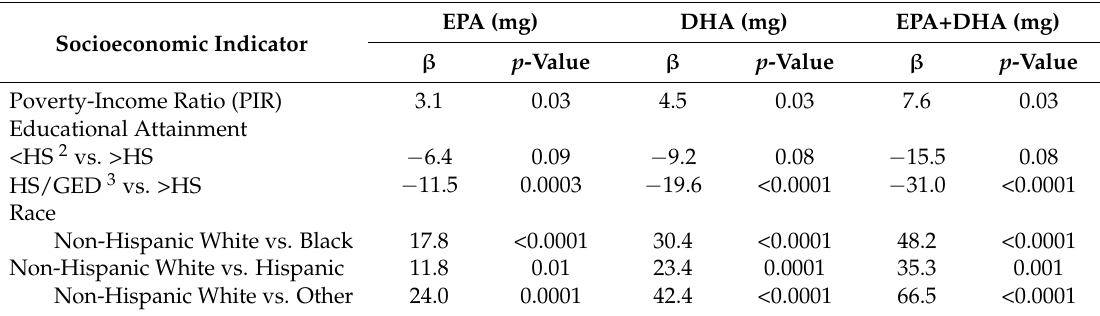
Table 5. Results of multivariate regression models of socioeconomic indicators and omega-3 fatty acid intake 1